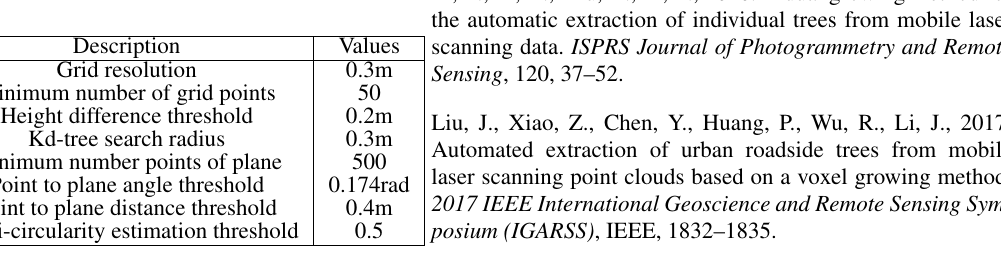
Table 3. Parameters settings for two experimental datasets The corresponding LVV is 707.50 m 3 , 2714.13 m 3 , and 8361.88 m 3 , the O 2 output, CO 2 absorption amount and SO 2 absorption amount are 22.39t/a, 30.87t/a, 35.70kg/a, respectively. Moreover, the annual dust retention amount is 12.96t, the transpiration amount in summer is